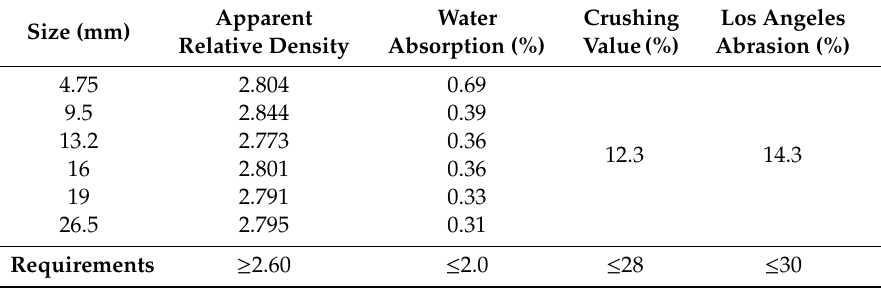
Table 2. Testing results of coarse aggregates.